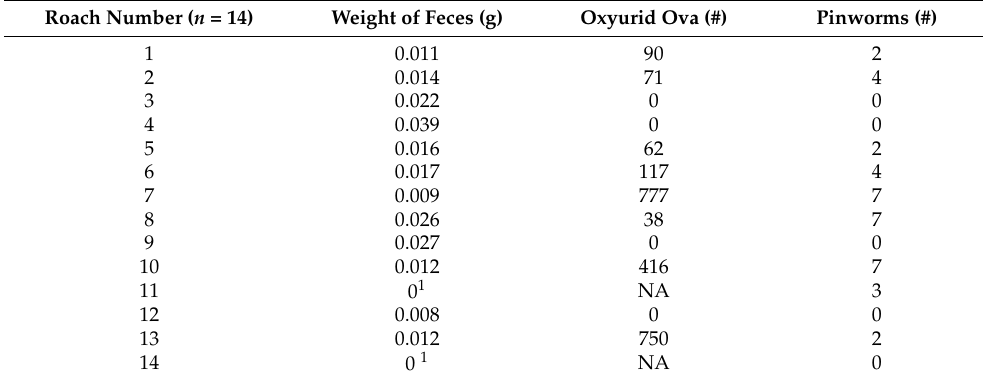
Table 1. Dubia roach, Blaptica dubia , 24 hr pre-treatment fecal total wet weight (g) and pinworm ova (#) and adult Leidynema appendiculata (#) confirmed from each roach on necropsy 2 days after fecal collections.